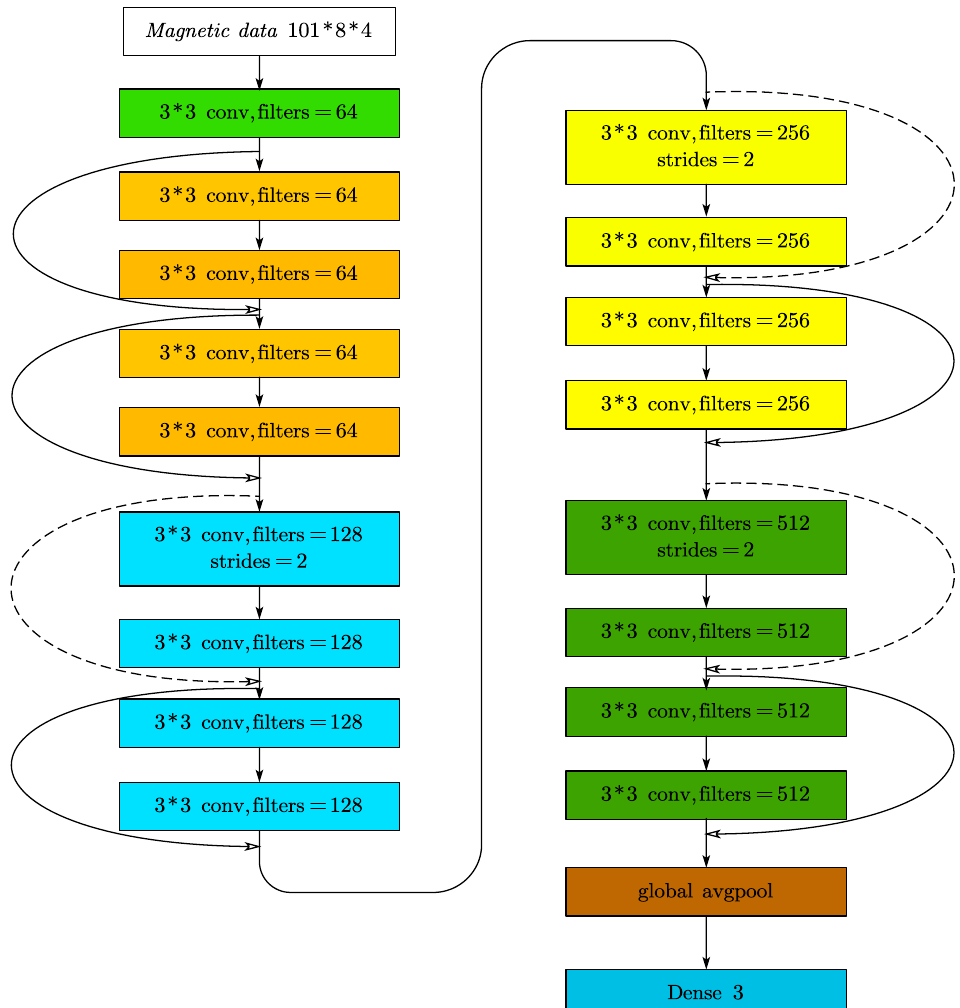
Figure 4. ResNet-18 network structure. The dotted line indicates that the dimensions are different, and it needs to be adjusted through a 1 * 1 convolution kernel to adjust to the same dimension.